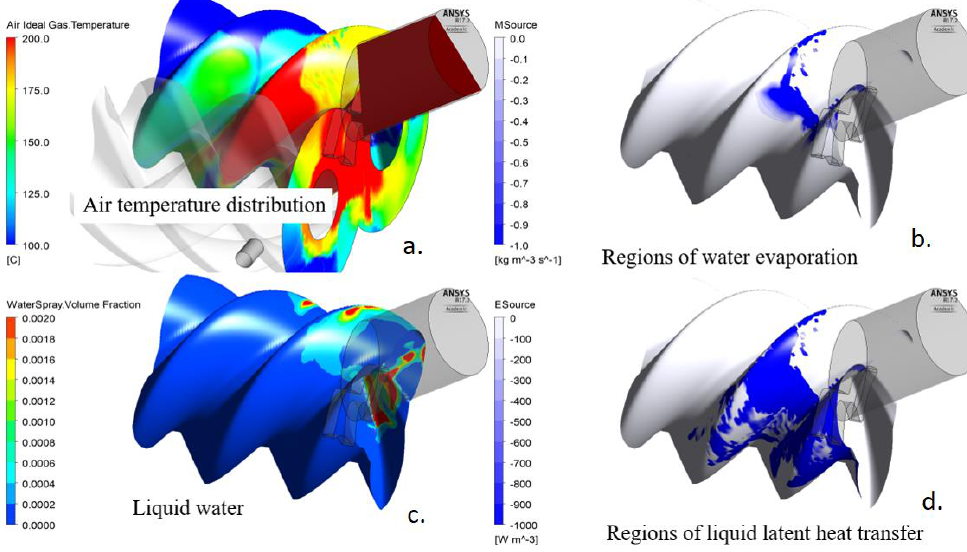
Figure 15. Visualization of Case 2: ( a ) air temperature distribution; ( b ) regions of water evaporation; ( c ) liquid water distribution; and ( d ), regions of liquid latent heat transfer.